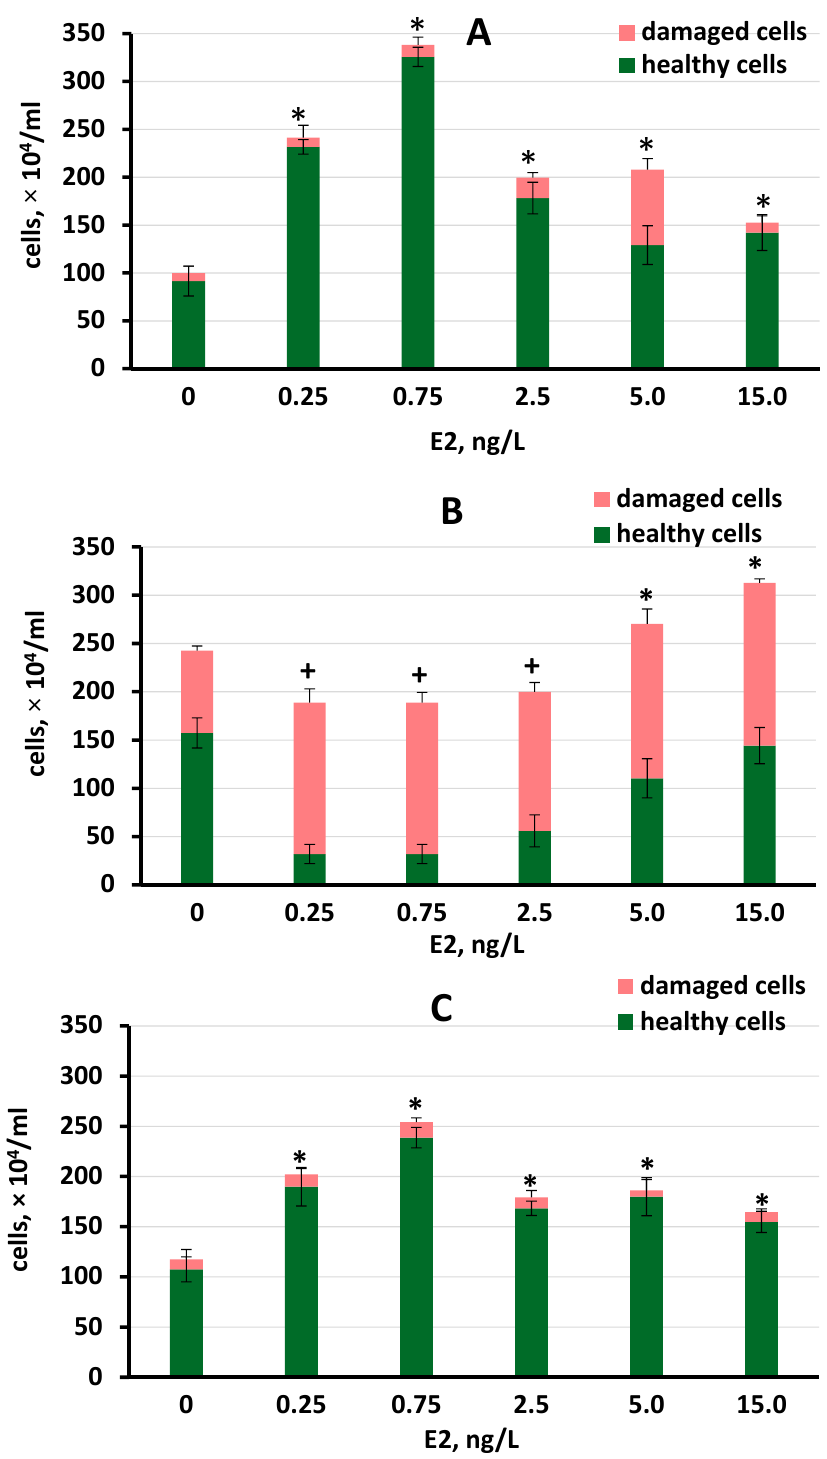
Figure 2. Cell density of S. quadricauda cultured in the three media containing E2 concentrations of 0.25 ng/L to 15 ng/L on day 11 of the experiment: ( A ) FFW; ( B ) RFWW; and ( C ) BBM. Statistically significant differences from the controls ( p < 0.05) are shown for the total cell density, where *— significantly greater than the control; +—significantly lower than the control. Data are shown as the mean ± SD, n = 15. Control cultures did not contain E2, indicated by “0”.